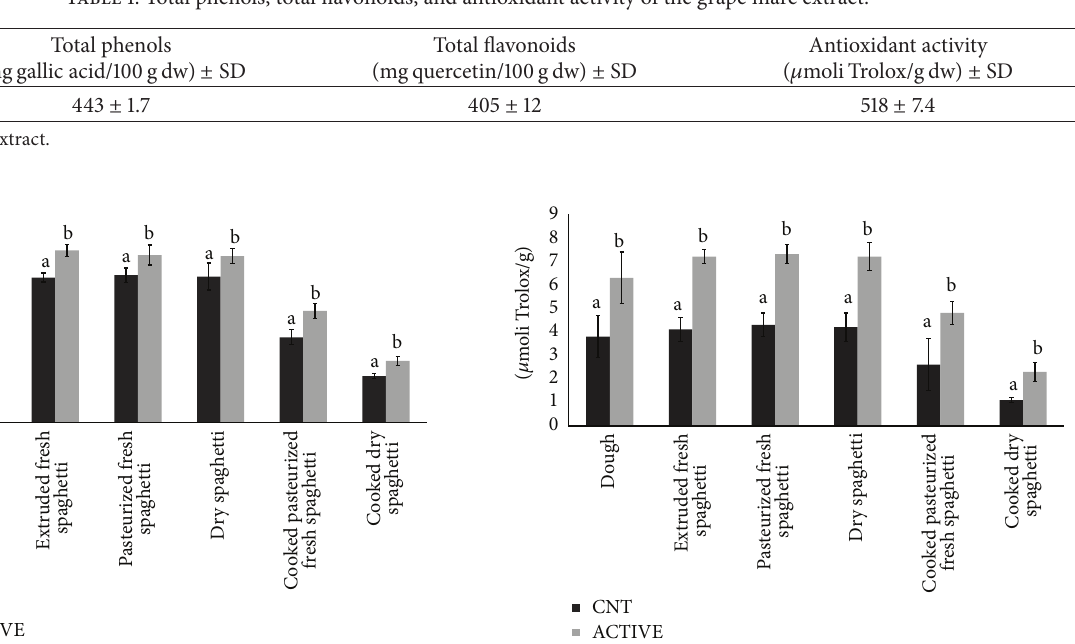
Figure 1: Total phenolic content of spaghetti samples in each step of the production process. Results are expressed as means ± SD for 𝑛 = 3 . a , b Data in columns with different superscripts are significantly different ( 𝑃 < 0.05 ). CNT: samples without the addition of grape marc extract; ACTIVE: samples with the addition of grape marc extract.